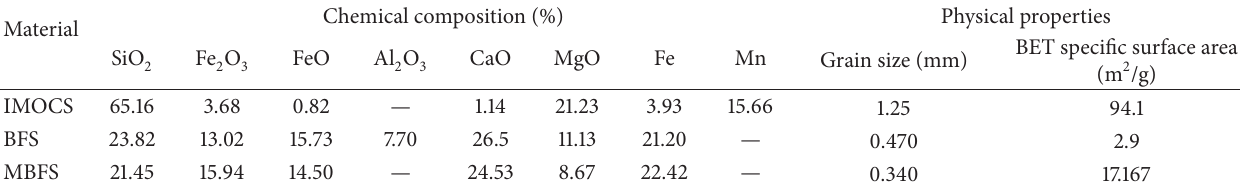
Table 1: Chemical composition and physical properties of the industrial by-products.